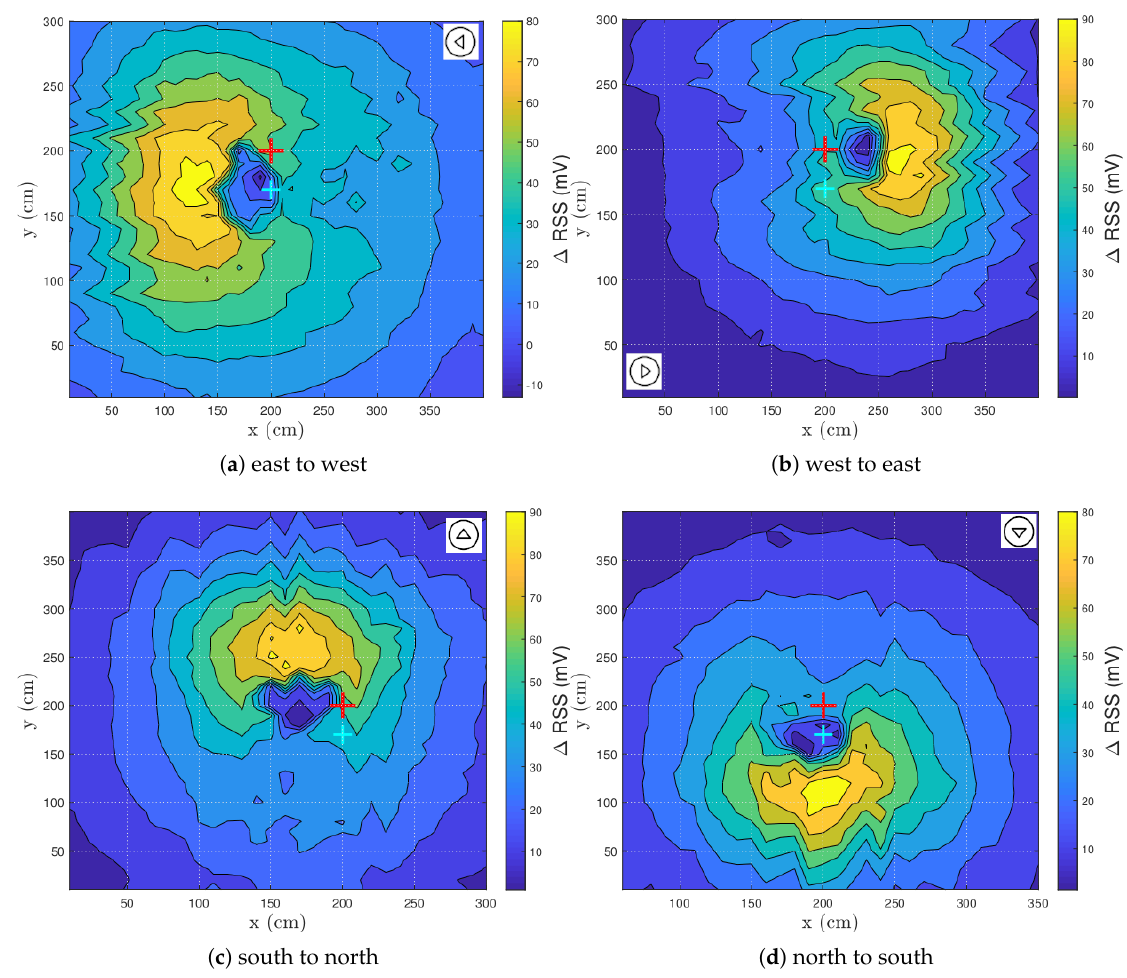
Figure 7. Visualization of the RSS distribution for different orientations. The red cross represents the LED, while the cyan cross denotes the